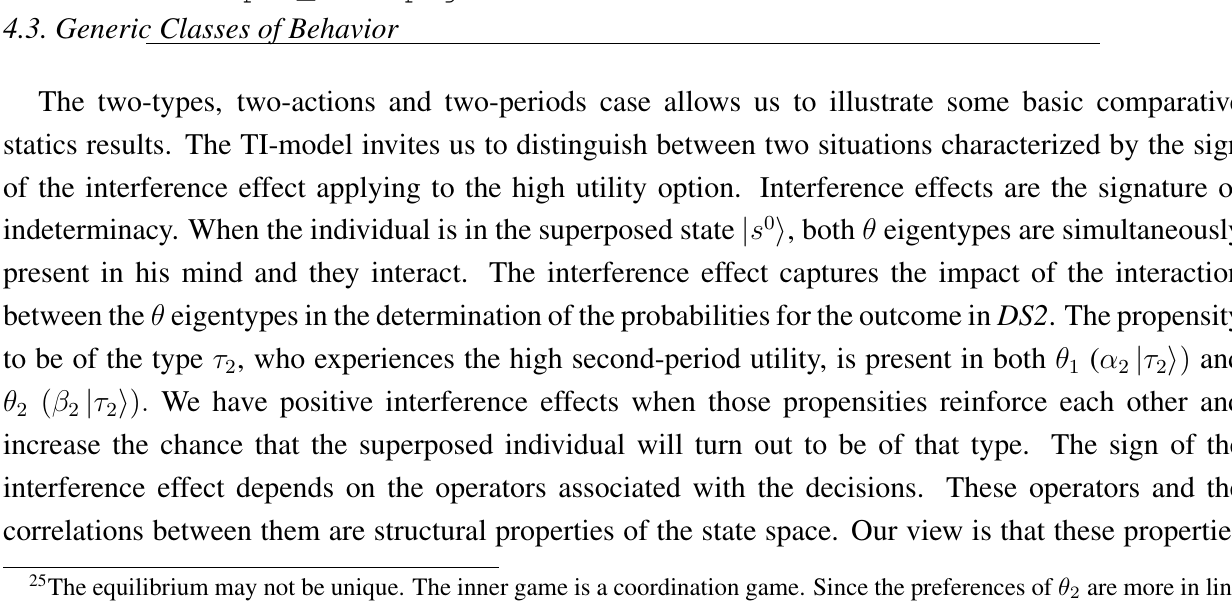
Figure 1. Multiple Selves game